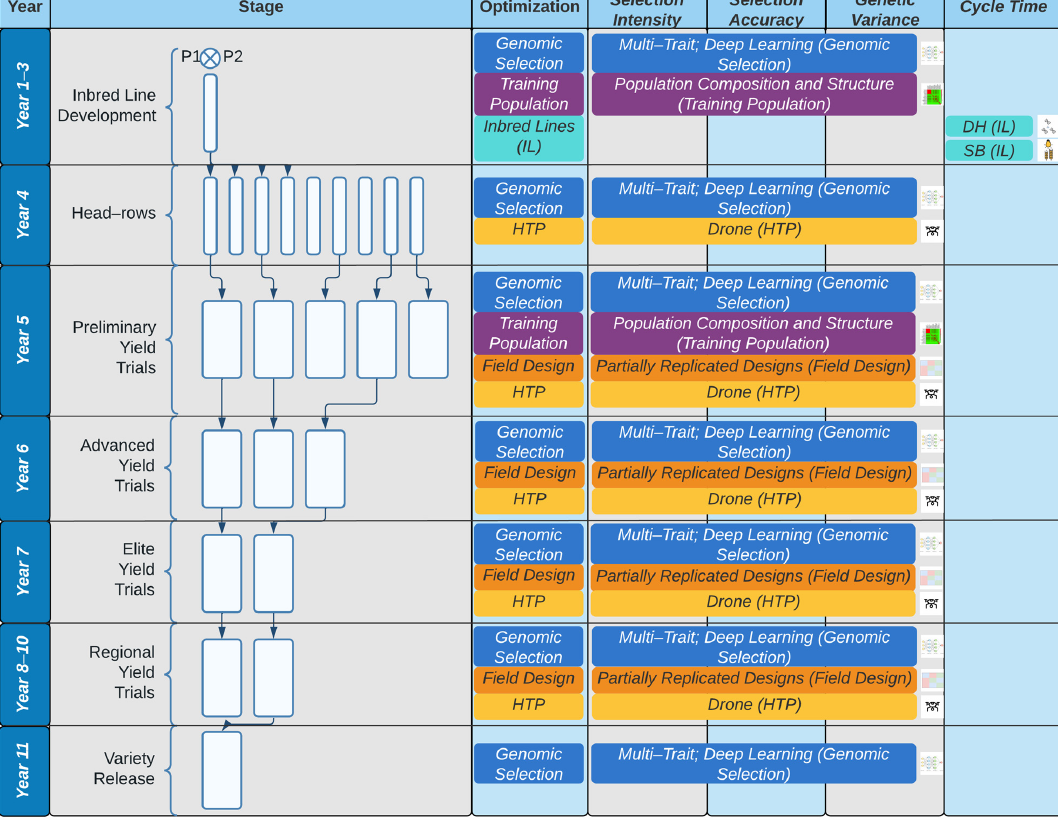
Figure 1. Optimization of the traditional breeding pipeline and product development based on an 11–year breeding program from parental crossing to variety release. The effect of each component of optimization (genomic selection, training population design, inbred line development, field design, high-throughput phenotyping (HTP) on different aspects of the breeder’s equation (selection intensity, selection accuracy, genetic variance, and cycle time) is shown by the coverage of the method of optimization within the respective column of the different factors of the breeder’s equation. For example, for Years 1–3 of the breeding cycle, the composition and structure of the training population (purple) affect both selection accuracy and genetic variance, whereas the choice of genomic selection models affects the intensity of selection, prediction accuracy, and genetic variance.